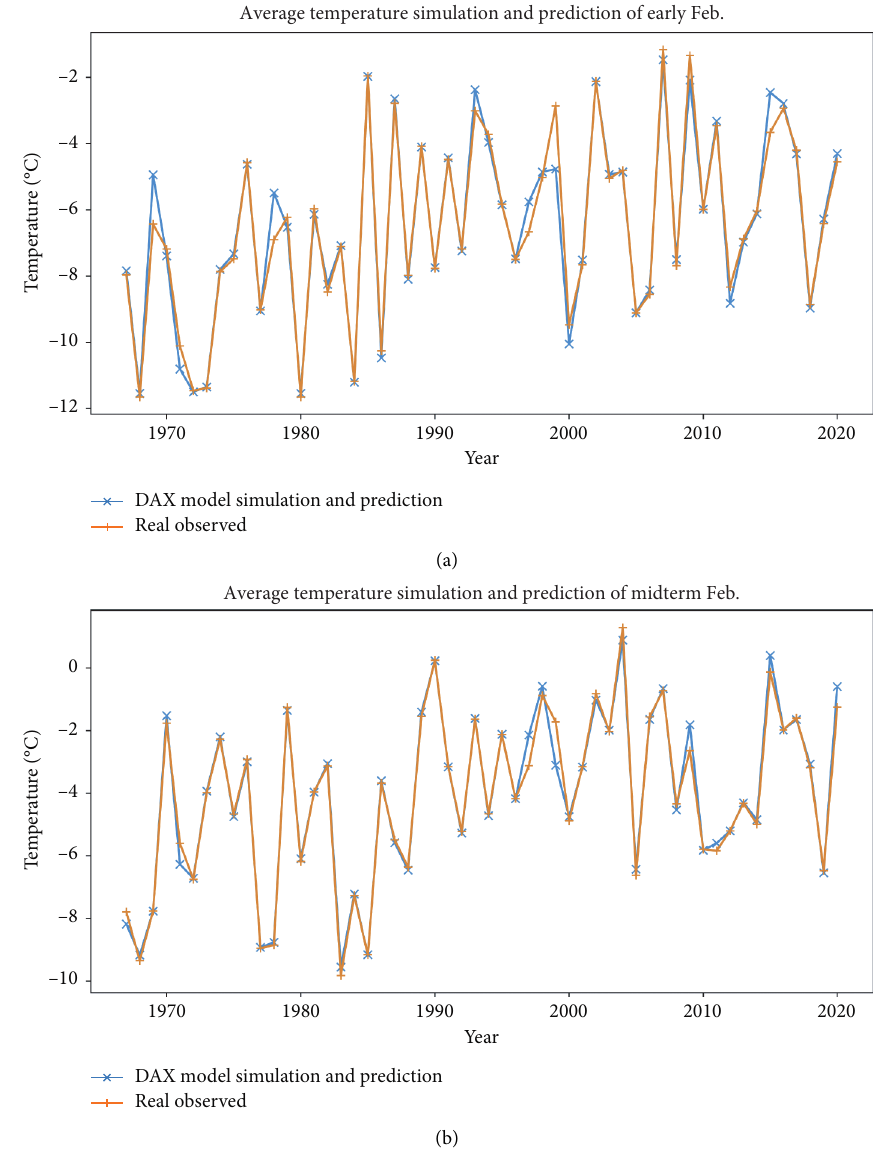
Figure 2: The prediction of DAX and its comparison with real value.